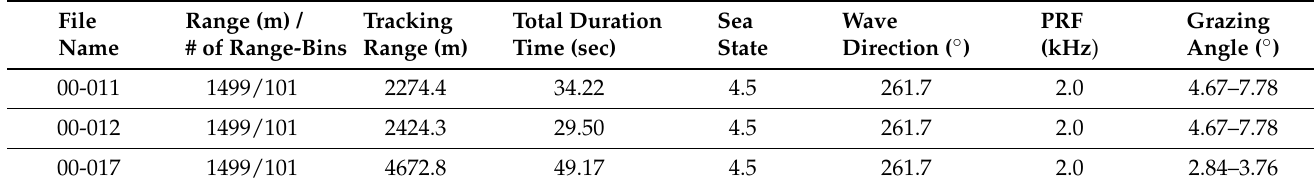
Table 1. Description of data sets